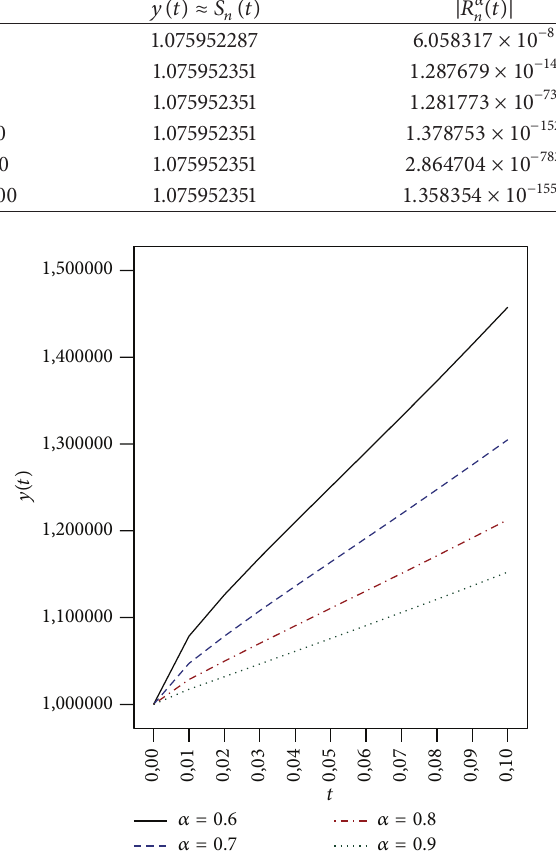
Figure 2: Approximate solutions obtained by GTSM in Example 2 for different order of